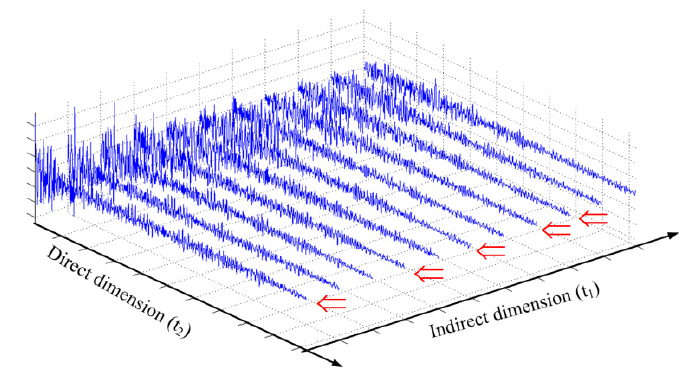
Figure 3. An example of random undersampling in the indirect dimension. The symbol ⇐ denotes the acquired